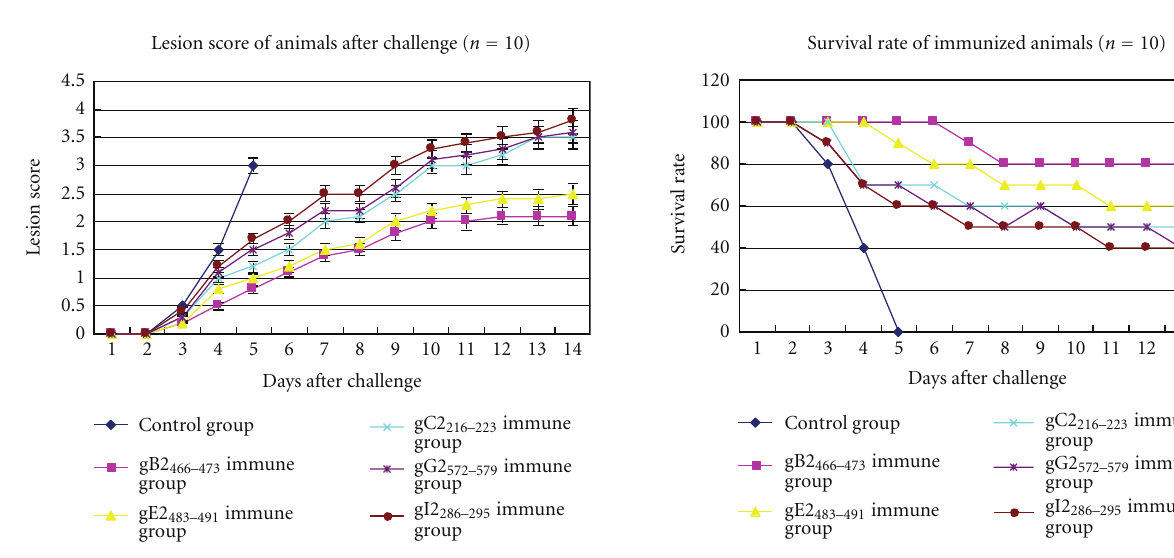
Figure 4: Survival rates of the immunized mice after the HSV-2